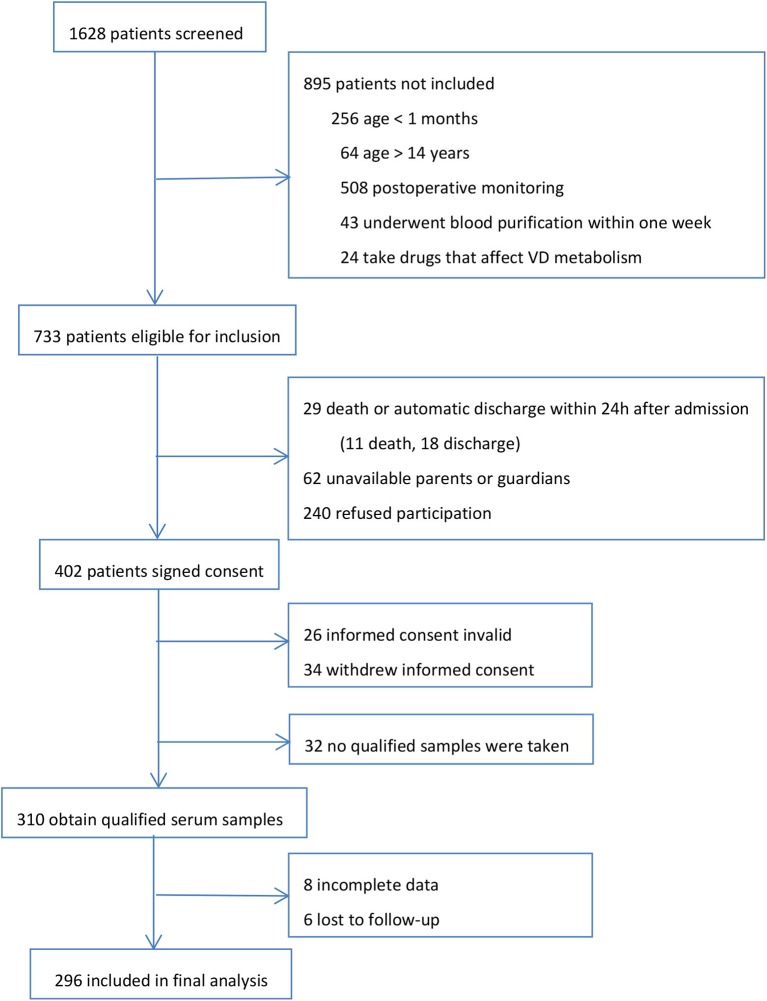
Research profile.